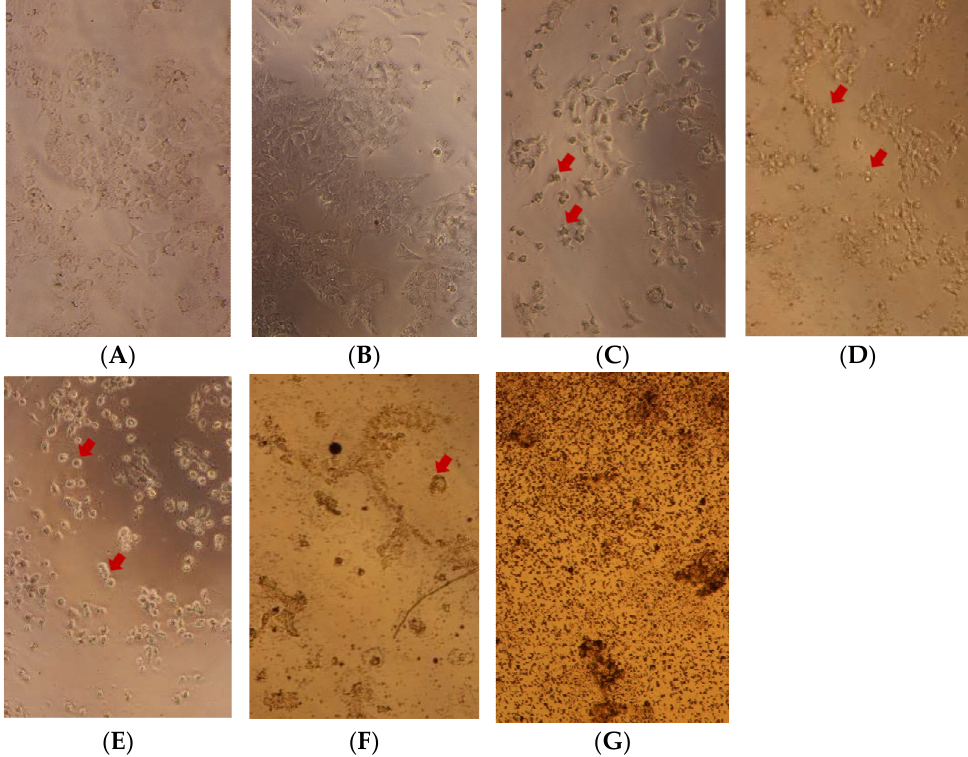
Figure 4. Direct microscope observations of Huh7 cancer cells treated with turmeric extracts at different concentrations (( A ); 0, ( B ); 31.25, ( C ); 62.50, ( D ); 125.00, ( E ); 250.00, ( F ); 500.00 and ( G ); 1000.00 µ g/mL) under a microscope with 10 × magnification compared with untreated control ( A ); red arrows present the morphology change of death